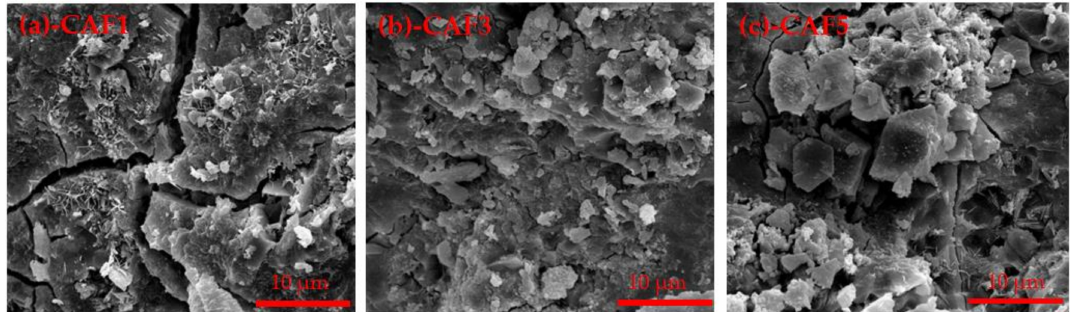
Figure 11. SEM of the different C 4 AF contents of the clinker hydrated at 3 days, ( a )-CAF1, ( b )-CAF3, ( c )-CAF5.